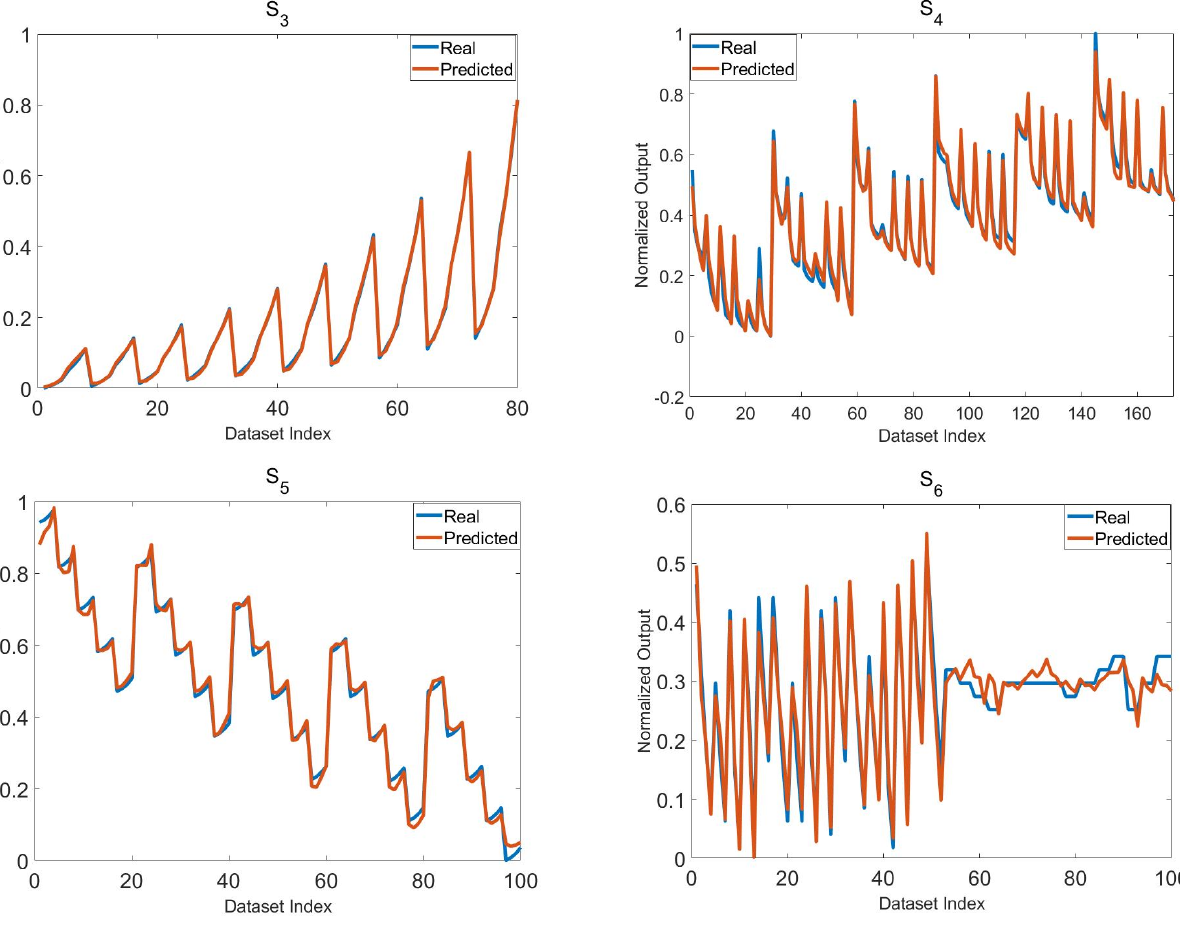
Figure 7. Comparison of the real output and the predicted output for nonlinear static system iden- tification.